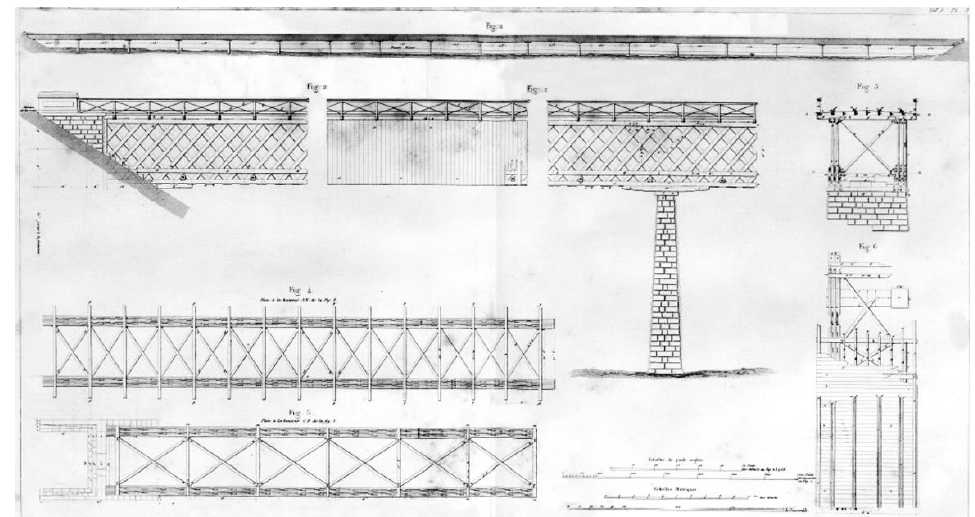
Figure 22. Bridge over the James River. Longitudinal elevation and section. Designed by M. Michel Chevalier, located in Richmond, Virginia. Source: “ Revue Générale de l ’ architecture et des Travaux Publics ” , France, 1840. Vol.1, (Pl.3). Edited by César Daly. Reference [16].